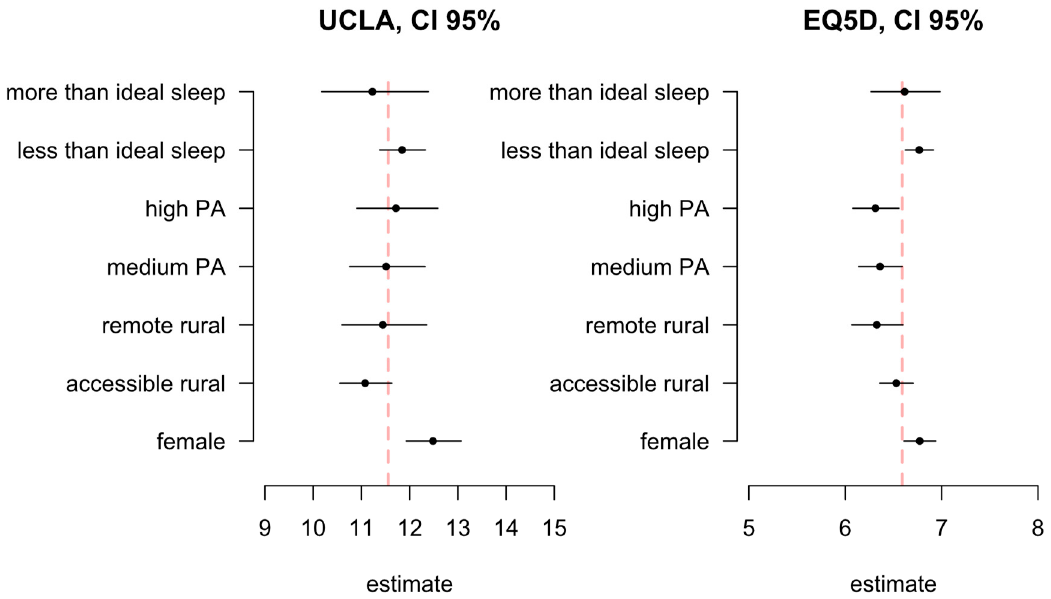
Figure 2. Associations with loneliness (UCLA, left ) and wellbeing (EQ5D-3L, right ) for categorical variables included in the model: sleep quantity, physical activity level, rurality, and gender. The dashed line indicates the model intercept (the model average when everything is kept at the reference category). The estimates have been transformed to match the outcome scale, for ease of interpretation.